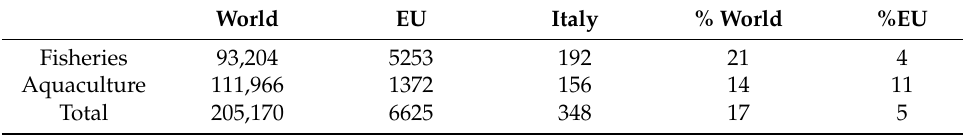
Table 4. Production of farmed fish in the world, in the EU and Italy ( × 1000 t). World